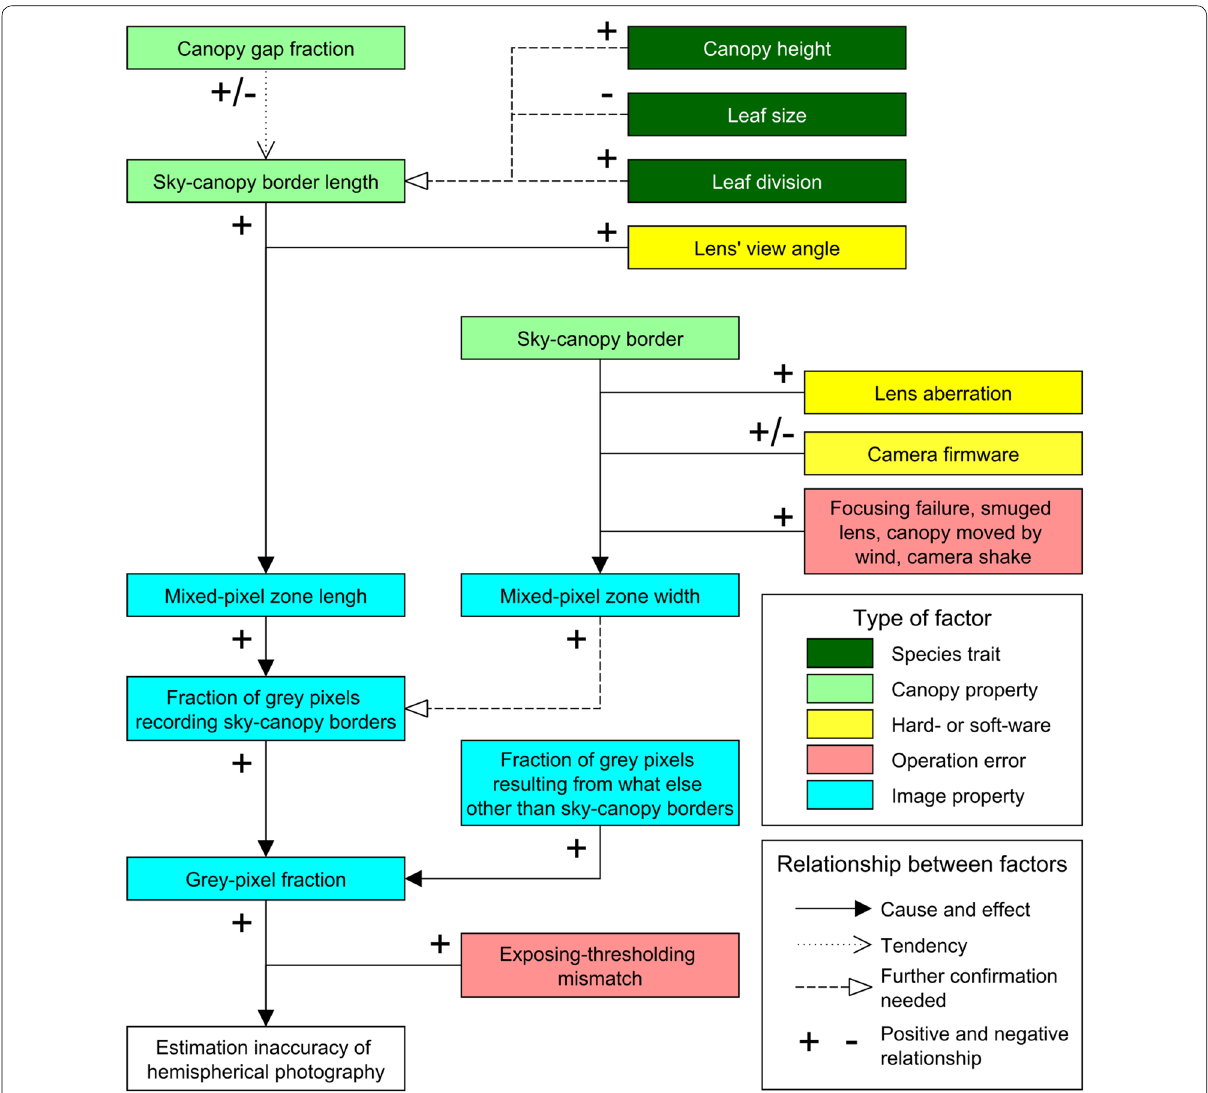
Fig. 11 Relationships between the estimation inaccuracy of HP and its influential factors. Minus and plus signs indicate negative and positive relationships,